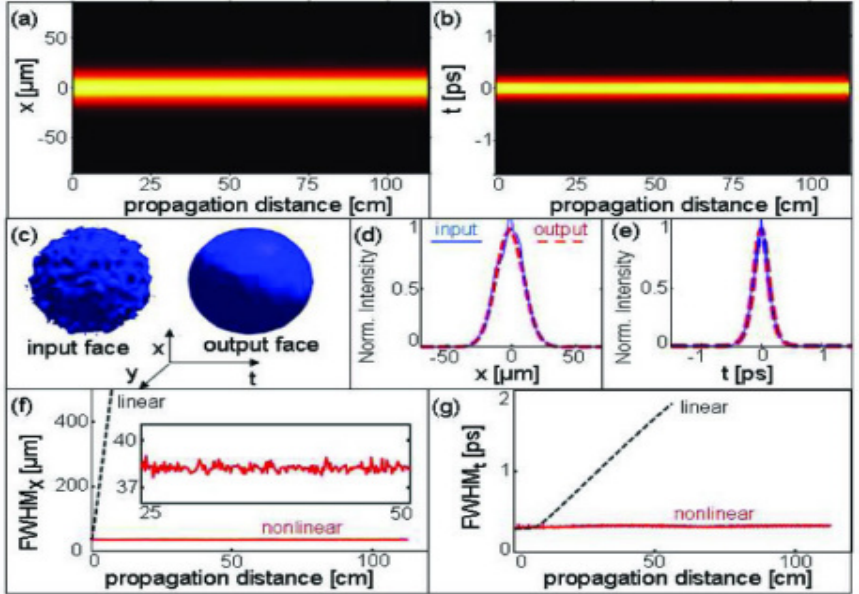
Figure 10. Temporally bright spatiotemporal pulse-train soliton. Intensity of the soliton in plane xz ( a ) and t-z ( b ) demonstrating the stationary propagation. ( c ) Intensity in x-y-t at the input and output faces of the sample. Intensity profiles in the x direction ( d ) and t direction ( e ) at the input and output faces of the sample. Width (FWHM) of the intensity in the x direction ( f ) and t direction ( g ) versus propagation distance for linear and nonlinear propagations. Reprinted with permission from [67] © The Optical Society.